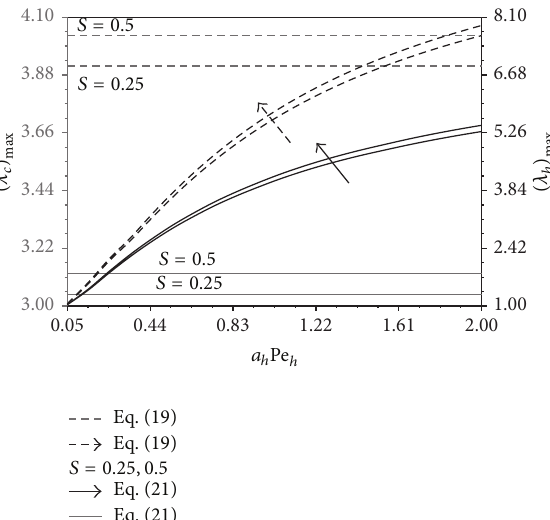
Figure 13: Effects of 𝑎 ℎ Pe ℎ and 𝑆 on (𝜆 ℎ ) max and (𝜆 𝑐 ) max (0.01 ≤ ≤ 0.25, 0.12 ≤ 𝑎 𝑎 𝑓 ( or ) 0 ≤ 𝐿 𝐵 𝑐